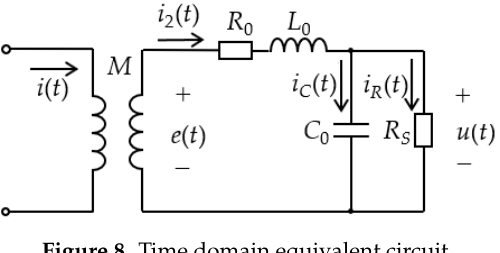
Figure 8. Time domain equivalent circuit.